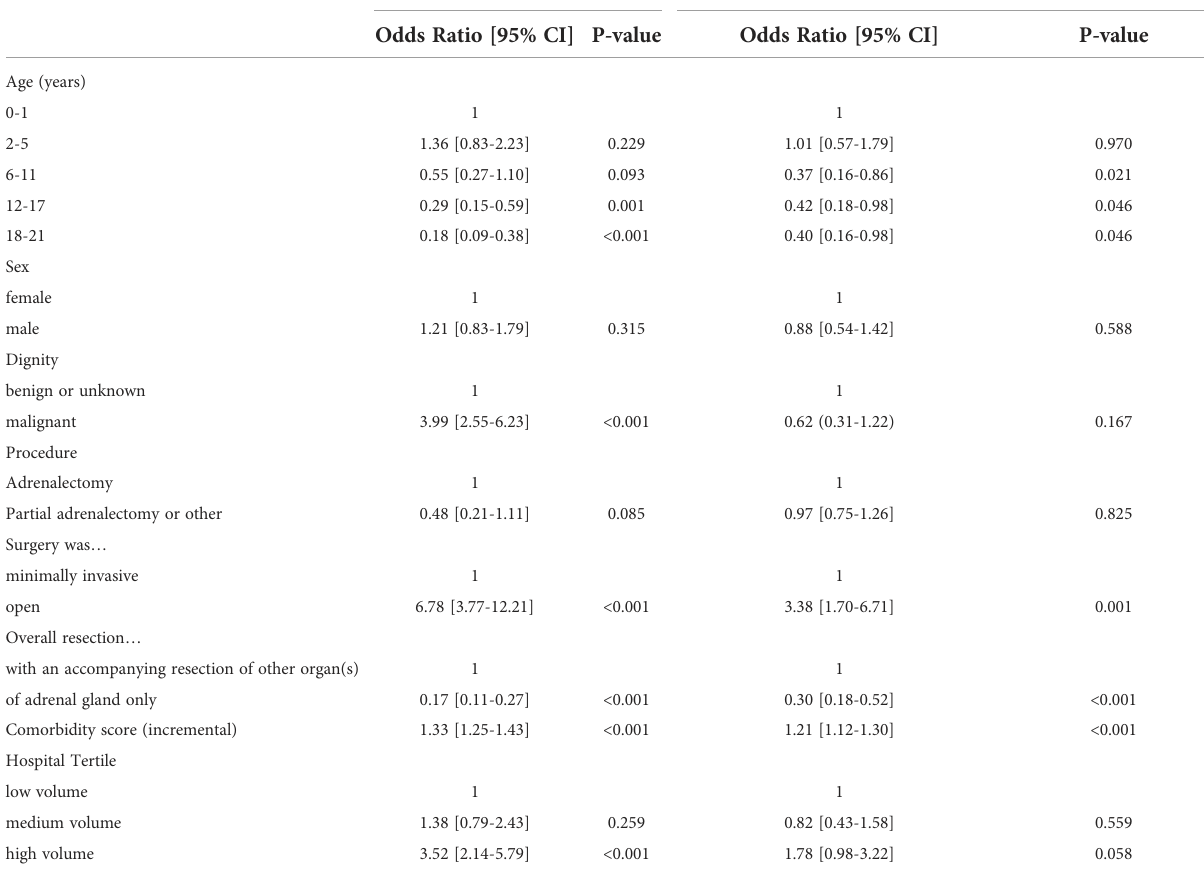
Unadjusted OR for in-hospital Multivariable logistic regression model for in-house complication